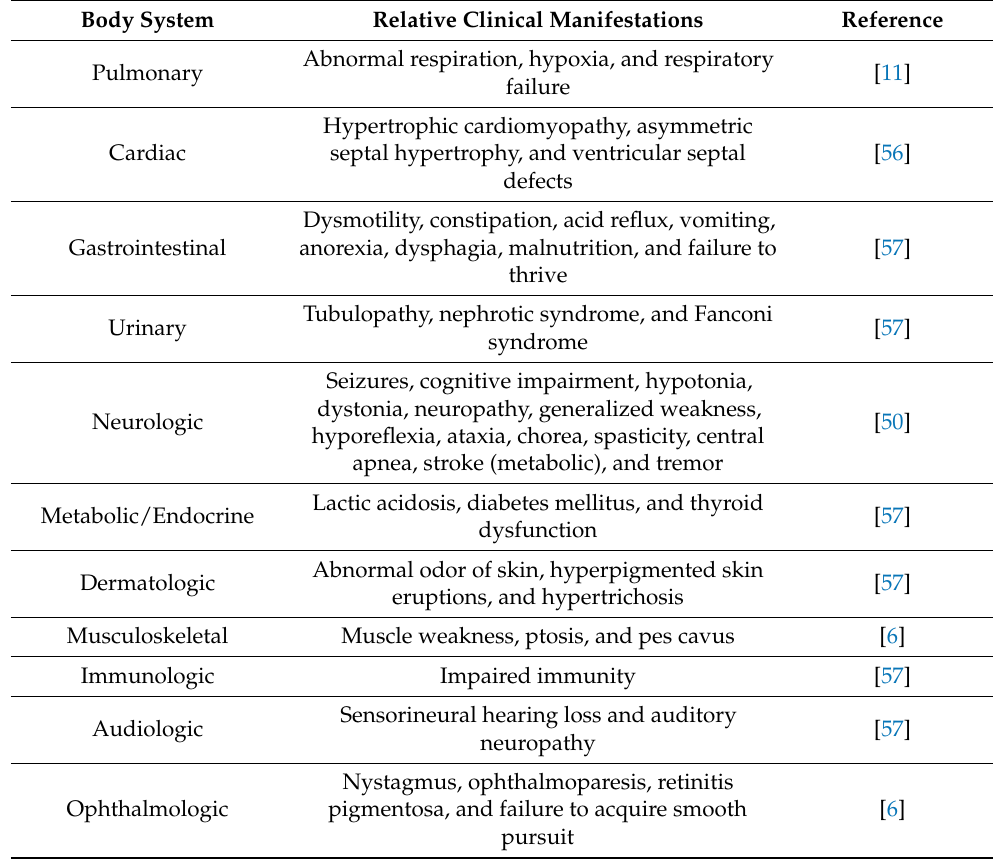
Table 2. Clinical manifestations of Leigh